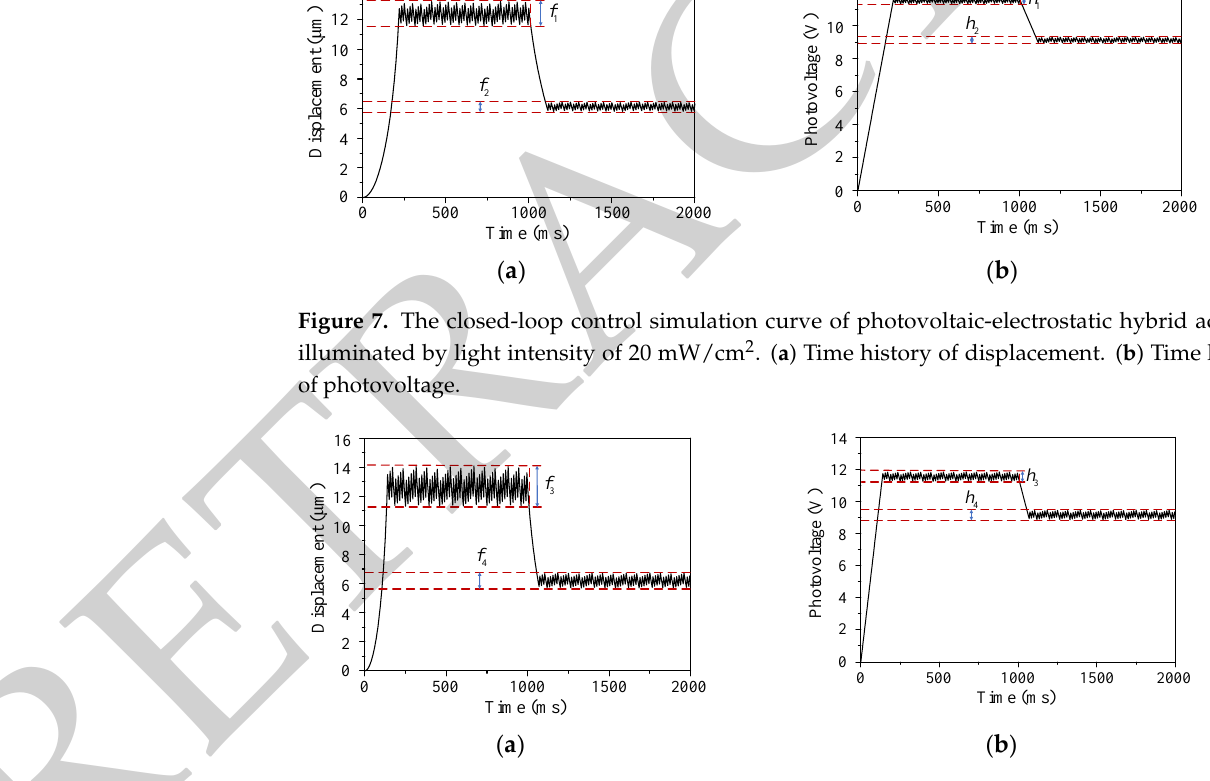
Figure 9. The closed-loop control simulation curve of photovoltaic-electrostatic hybrid actuator il- luminated by light intensity of 60 mW/cm 2 . ( a ) Time history of displacement. ( b ) Time history of photovoltage. As illustrated in Figure 7a, when the light intensity is 20 mW/cm 2 , it takes about 220 ms for the displacement of the upper electrode tip to increase to 12 μm. The maximum range of the fluctuation of f 1 is about 1.6 µm for a target displacement of around 12 µm, and about 0.8 µm for f 2 for a target displacement of around 6 µm. The corresponding pho- tovoltage simulation curve is shown in Figure 7b. The maximum ranges of the fluctuation of h 1 and h 2 are about 0.4 V for target photovoltages of around 11.43 V and 9.05 V. As illustrated in Figure 8a, when the light intensity is 40 mW/cm 2 , it takes about 140 ms for the displacement of the upper electrode tip to increase to 12 μm. The maximum range of the fluctuation of f 3 is about 2.9 µm for a target displacement of around 12 µm,